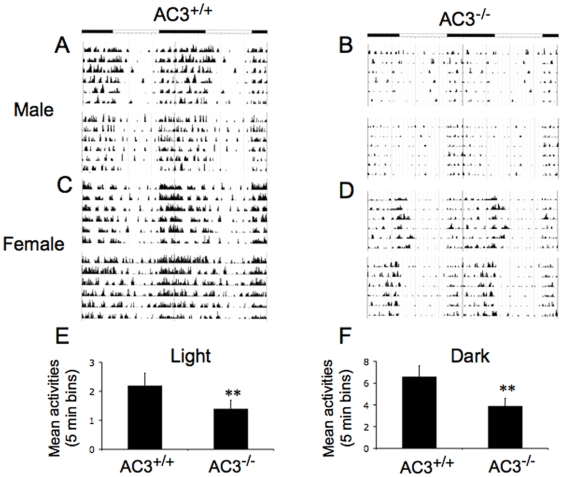
Young AC3−/− mice demonstrate decreased locomotor activity.(A,B,C,D) Representative locomotor activity of two mice for 6 days: AC3+/+ male mice (A), AC3−/− male mice (B), AC3+/+ female mice (C), and AC3−/− female mice (D). (E) Average activity of AC3+/+ and AC3−/− mice in the light phase. (F) Average activities of AC3+/+ and AC3−/− mice in the dark phase. For (E,F), N = 12 mice at an age of 2 months. There is a significant difference in locomotor activity between AC3+/+ and AC3−/− mice in the light and dark phases. **, p<0.01.